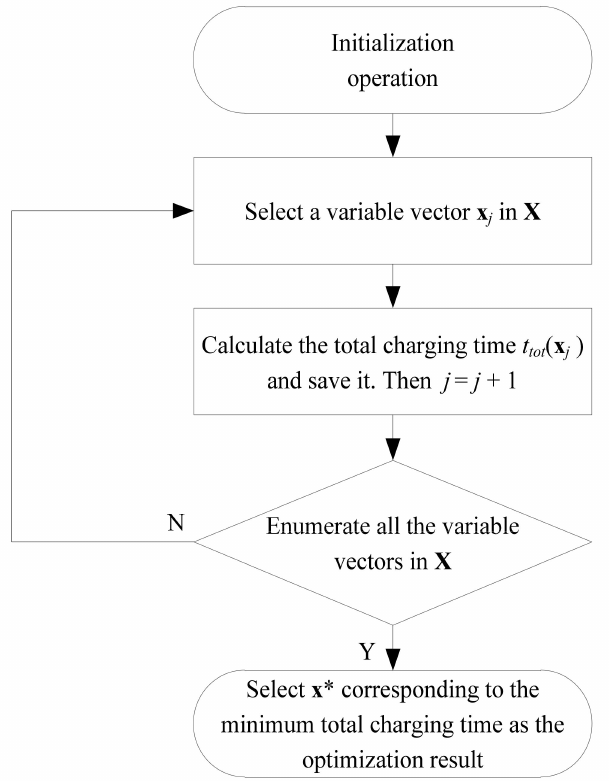
Figure 7. The flow chart of the procedures for the total charging time calculation and comparison.